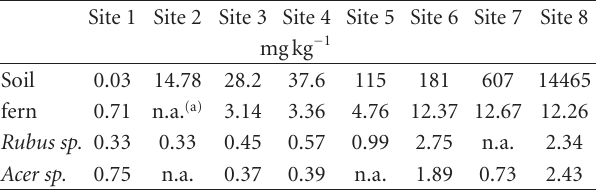
Table 2: Mercury concentration of surface horizons and of leaf tissues of three di ff erent species taken at di ff erent sites in the contaminated area, except site 1, which is a noncontaminated site located 300 km away from the study area but under similar climatic